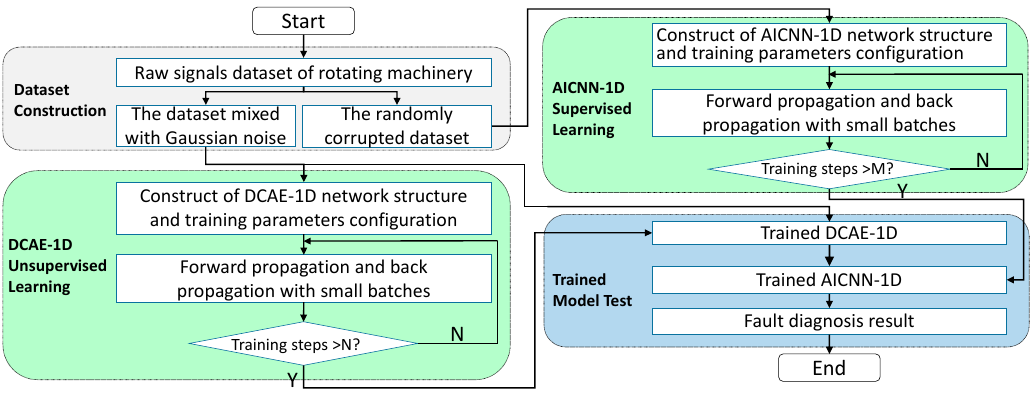
Figure 4. Flowchart of the proposed method.